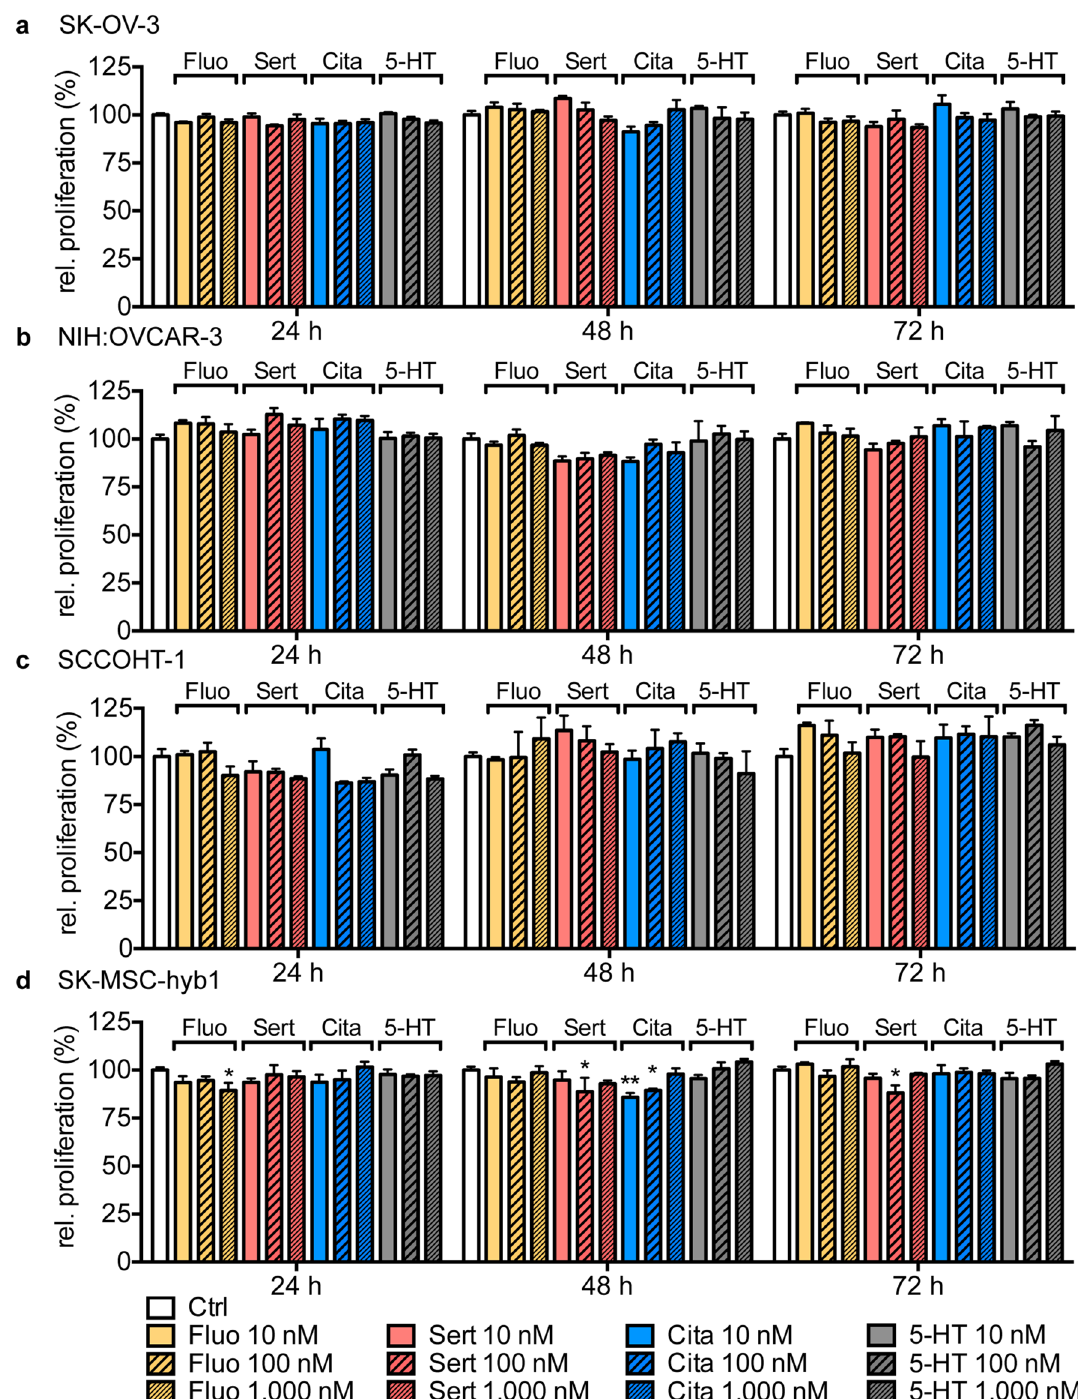
Figure 2. SSRI treatment and 5-HT stimulation have little effect on proliferation rates of ovarian cancer cell lines. Bar graphs depict relative proliferation measured by Fluoroskan of SK-OV-3 ( a ), NIH:OVCAR-3 ( b ), SCCOHT-1 ( c ) and SK-MSC-hyb1 ( d ) cells in response to exposure to 10 nM, 100 nM or 1000 nM fluoxetine (Fluo; yellow), sertraline (Sert; red), citalopram (Cita; blue) or 5-HT (grey) for indicated time periods normalized to DMSO-treated control cells (Ctrl; white). Data are depicted as mean ± SEM and summarize n = 10 (Ctrl) and n = 3 (SSRI/5-HT) experiments. P -values were determined by two-way ANOVA followed by Dunnett’s multiple comparison test, *** P < 0.001; ** P < 0.01; * P < 0.05 versus corresponding